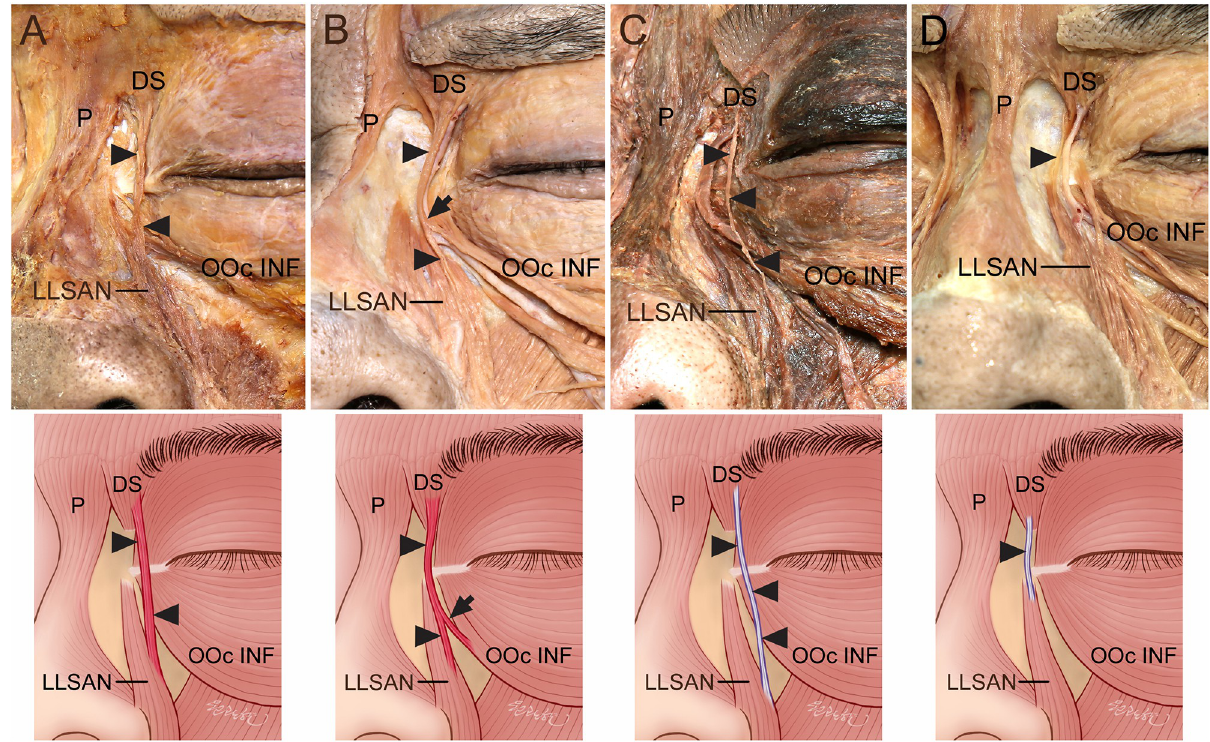
Fig 1. Connection of the DS to the LLSAN. (A) The DS was connected to the originating fibers of the LLSAN by the muscle fibers (arrowheads). (B) Some connecting muscle fibers (arrowheads) between the DS and LLSAN were connected with the OOc INF (arrows). (C) The DS was connected to the middle portion of the LLSAN by a thin aponeurosis (arrowheads). (D) The DS was connected to the originating fibers of the LLSAN by a thin aponeurosis